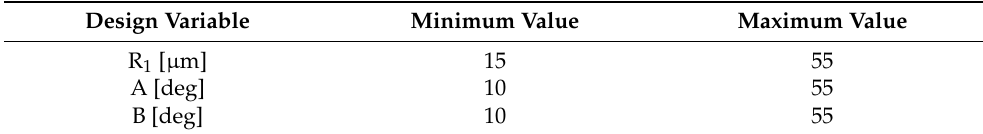
Table 2. Variation range of the design variables. Design